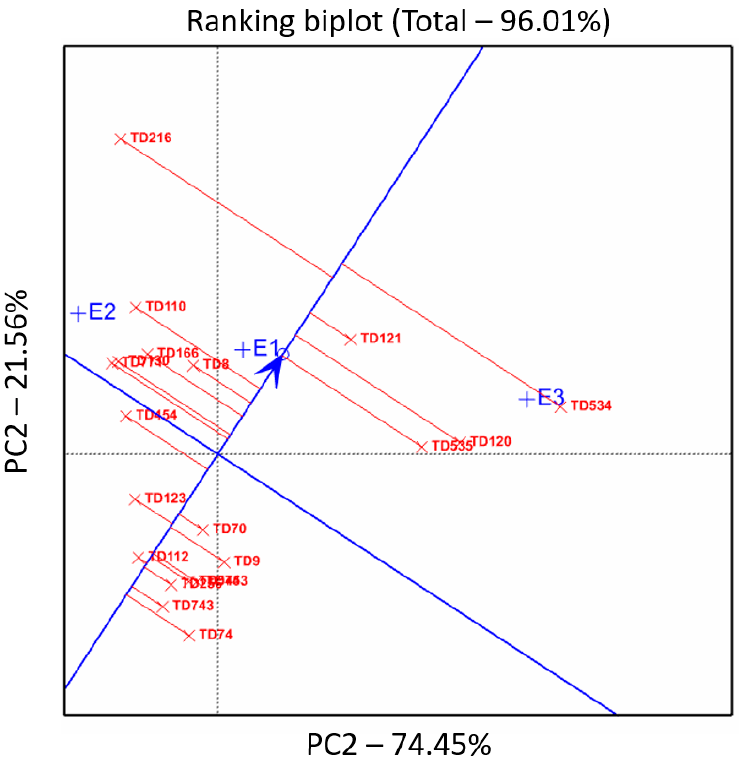
Figure 8. The ATC (Average Tester Coordinates) view of GGE biplot of yield–trait combination for the top 20 accessions in three environments (E1, E2, and E3) to rank them based on superiority index and to observe their stability across environments.